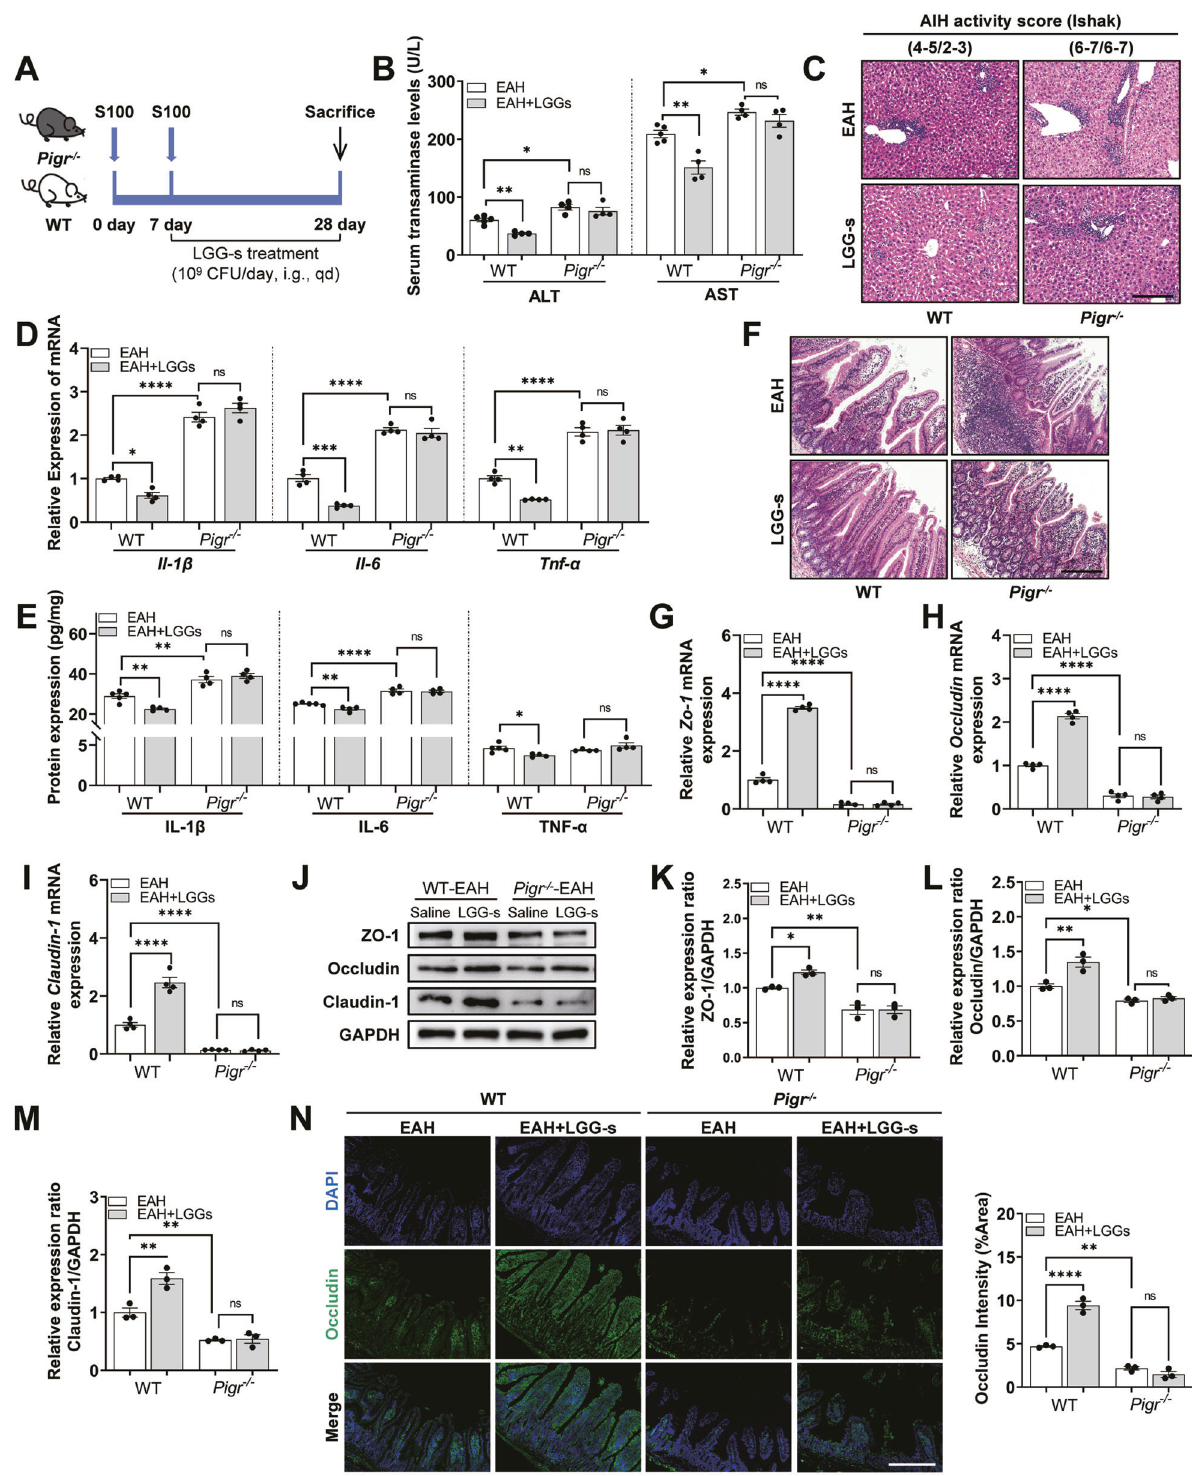
Fig. 5 Effects of Pigr on Lactobacillus rhamnosus GG culture supernatant (LGG-s) treatment in EAH. A Schematic of the LGG-s treatment regimen for WT and Pigr − / − -EAH mice. Mice were intraperitoneally injected with S100 on days 0 and 7, followed by i.g. with LGG-s (10 9 CFU/ml) or normal saline every day until day 28. B Serum ALT and AST levels. C , F H&E staining of the liver and intestine in mice. Scale bar = 200 μ m. D , E Hepatic gene and protein expression of pro-in fl ammatory cytokines IL-1 β , TNF- α , and IL-6. G – I Gene expression of Zo-1 , Occludin , and Claudin-1 . J – M Western blotting analysis for ZO-1, Occludin, and Claudin-1 normalized by GAPDH. N IF staining and quanti fi cation of Occludin. Scale bar = 200 μ m. Data are presented as mean ± SEM. Statistical analysis was performed using one-way ANOVA with Tukey multiple